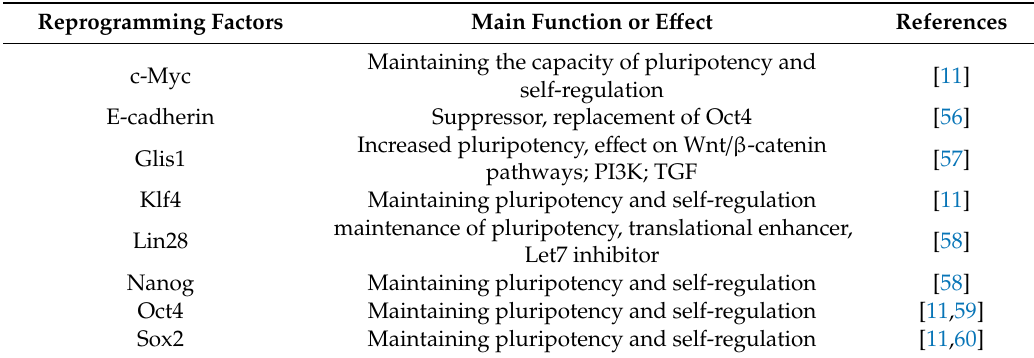
Table 3. Overview of the most frequently used reprogramming factors for iPSC derivation. Revised by